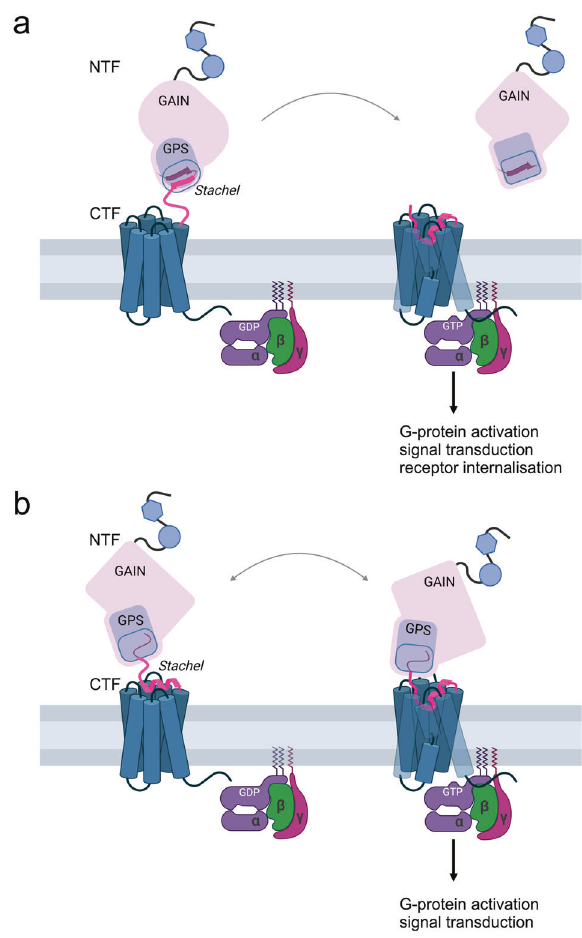
Fig. 1 Potential activation of G-protein signalling of aGPCRs by their tethered agonist. a Irreversible dissociation model: In the inactive stage, the Stachel sequence is located as a β -sheet (magenta) within the GAIN domain. Following an adequate signal (e.g., mechanical force or ligand binding) the N-terminal fragment (NTF) is removed. The tethered agonist is exposed and binds to the 7TMD in the form of an α -helix resulting in G-protein activation. Because the NTF dissociates from the CTF, the receptor needs to be internalised and degraded for inactivation and cannot undergo another activation cycle (not shown). β arrestin-mediated as well as β arrestin- independent mechanisms have been described for aGPCR inter- nalisation. b Reversible isomerisation model: In the inactive stage, the Stachel sequence is prebound as an α -helix to the 7TMD in its inactive or partially active conformation. Following receptor activa- tion, the Stachel sequence isomerises into the fully active conformation resulting in G protein-mediated signalling. Because NTF and CTF remain attached, multiple activation cycles are possible and receptor internalisation is not mandatory, but might eventually also occur after receptor activation. The fi gure was created with